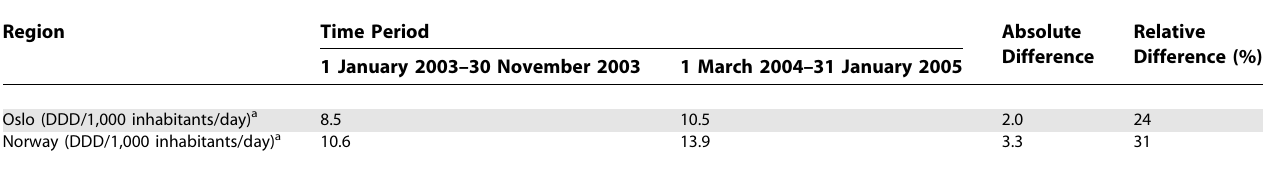
Table 4. Total Sales of Thiazides (ATC Codes C03A and C03E) in Oslo and All of Norway